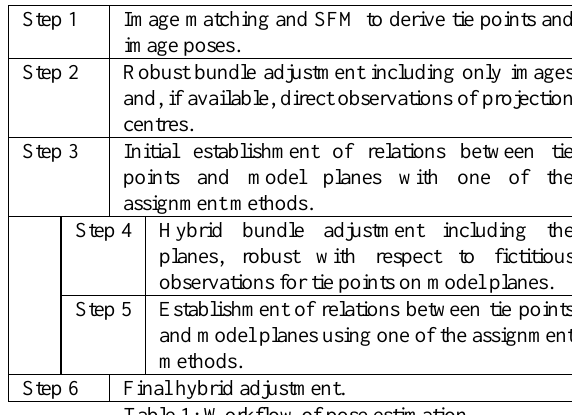
Table 1: Workflow of pose